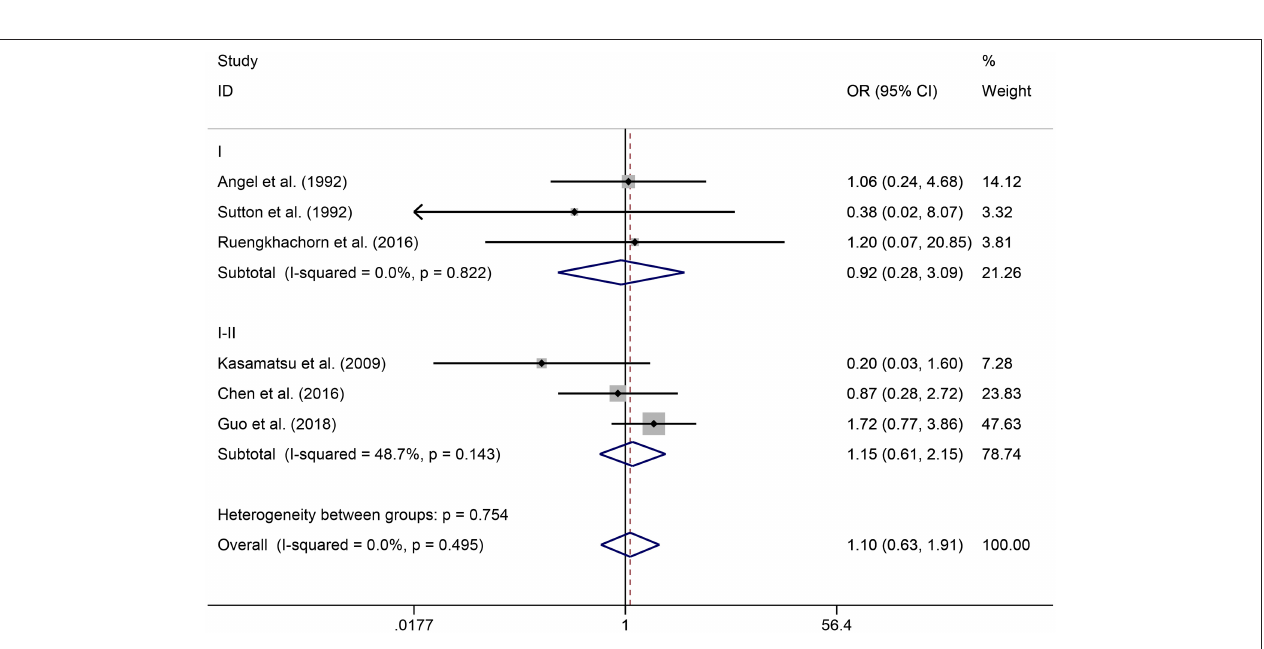
FIGURE 4 | Subgroup analysis of OS for ovarian preservation vs. oophorectomy in early stage cervical adenocarcinoma. Weights were from fixed-effects model.